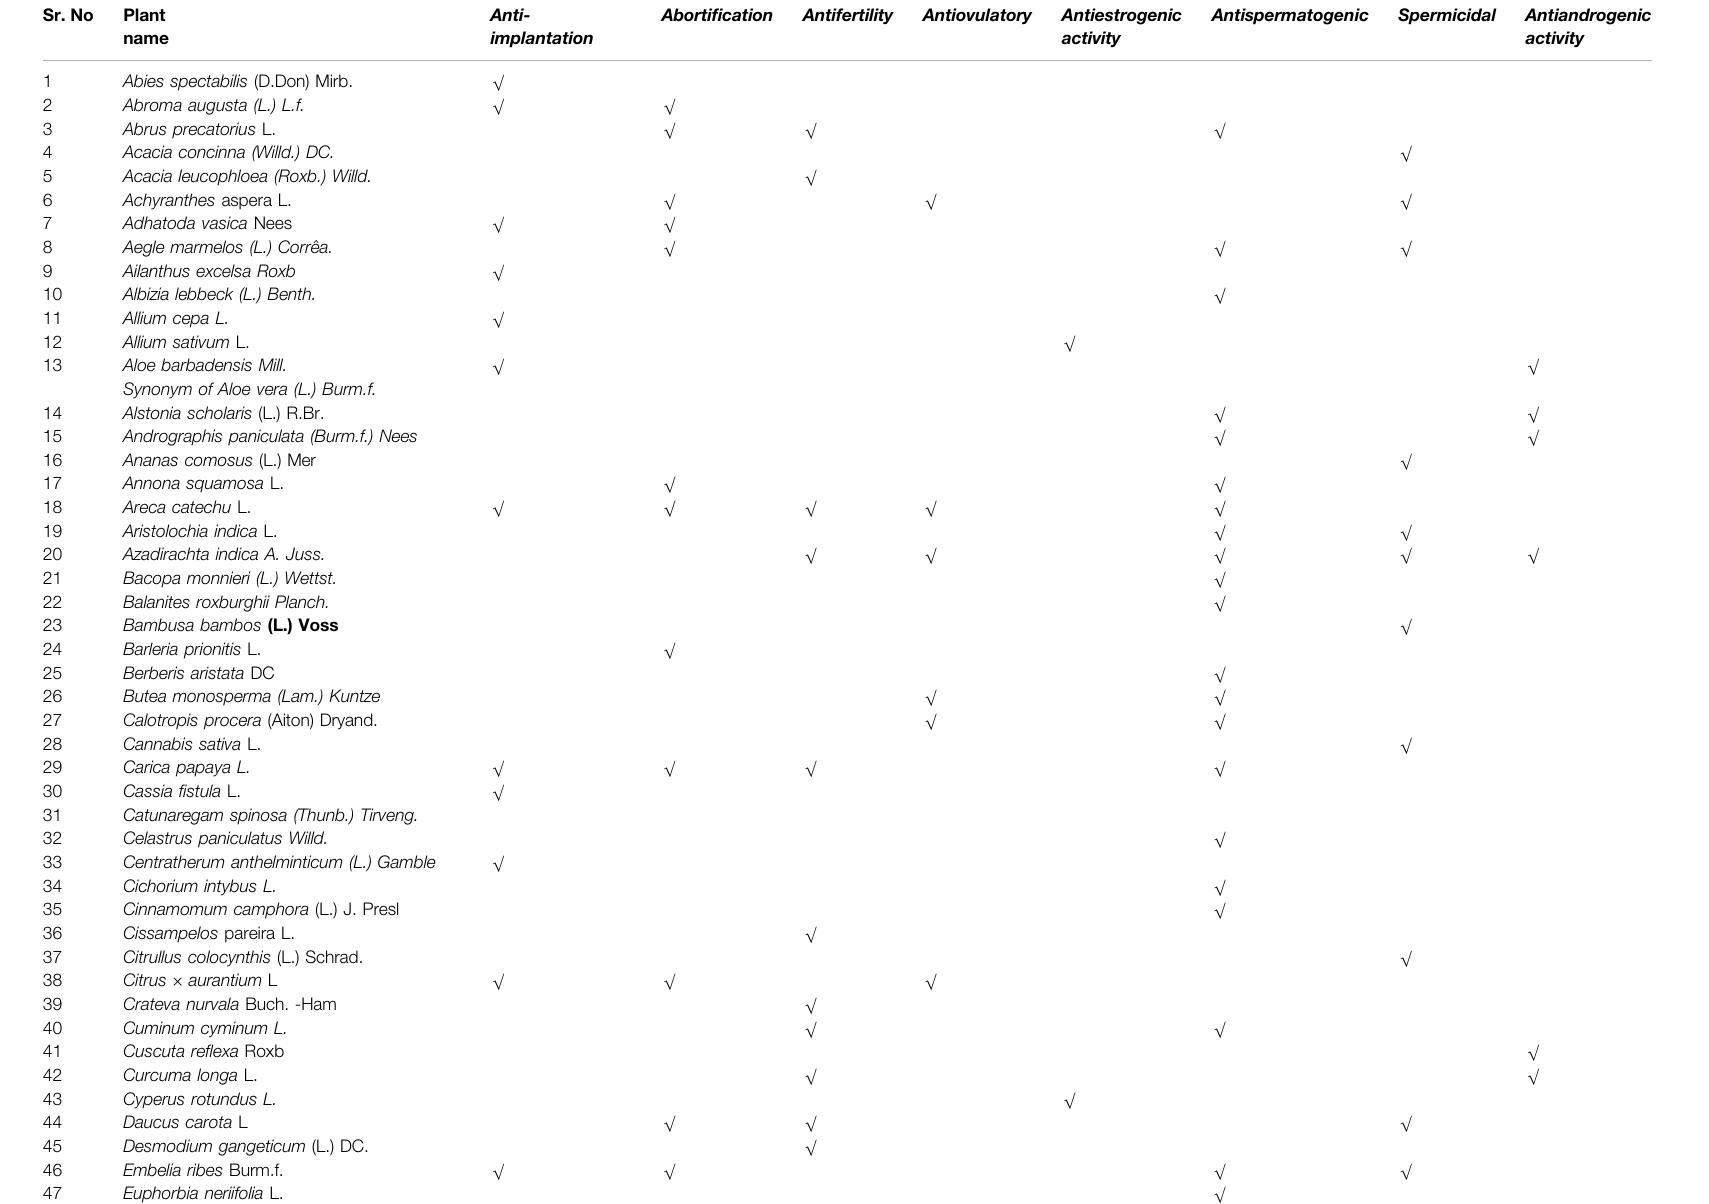
TABLE 4 | List of medicinal plants with one or more contraceptive